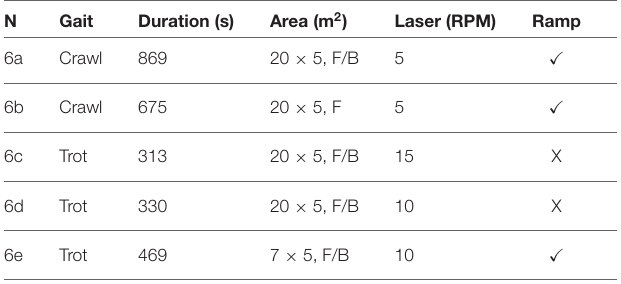
TABLE 3 | Detailed summary of the dataset used for Experiment 6, including log duration, size of arena, type of motion (F/B = forward/backward trajectory), laser spin rate, and terrain features.